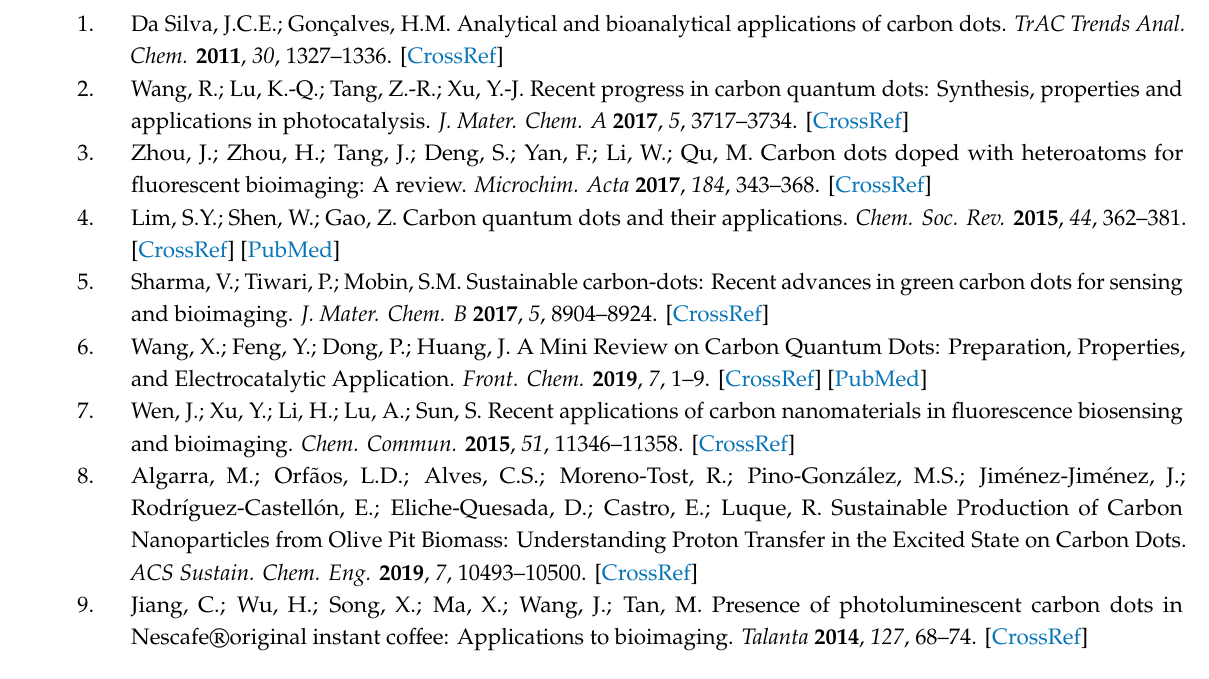
Figure S1: Detailed XPS spectra of C 1s (carbon dots 1 to 5); Figure S2: Detailed XPS spectra of O 1s (carbon dots 1 to 5); Figure S3: Detailed XPS spectra of N 1s (carbon dots 1 to 5); Figure S4: Absorbance spectra of carbon dots 1A, 1B, and 1C; Figure S5: XPS spectra C 1s (left) and N 1s (right) for carbon dots 1A, 1B, and 1C; Figure S6: Relative environmental impacts of each carbon dots solution with the ReCiPe2016 LCIA for: (A) CDs 1B, (B) CDs 2, (C) CDs 3, (D) CDs 4, and (E) CDs 5; Table S1: Contributions (%) to C 1s peaks after deconvolution (CasaXPS software); Table S2: Contributions (%) to O 1s peaks after deconvolution (CasaXPS software); Table S3: Contributions (%) to N 1s peaks after deconvolution (CasaXPS software); Table S4: Quantity of products required for the production of 1 kg of CDs (SimaPro software); Table S5: Fluorescence quantum yields (QY FL ) and QY FL -based functional